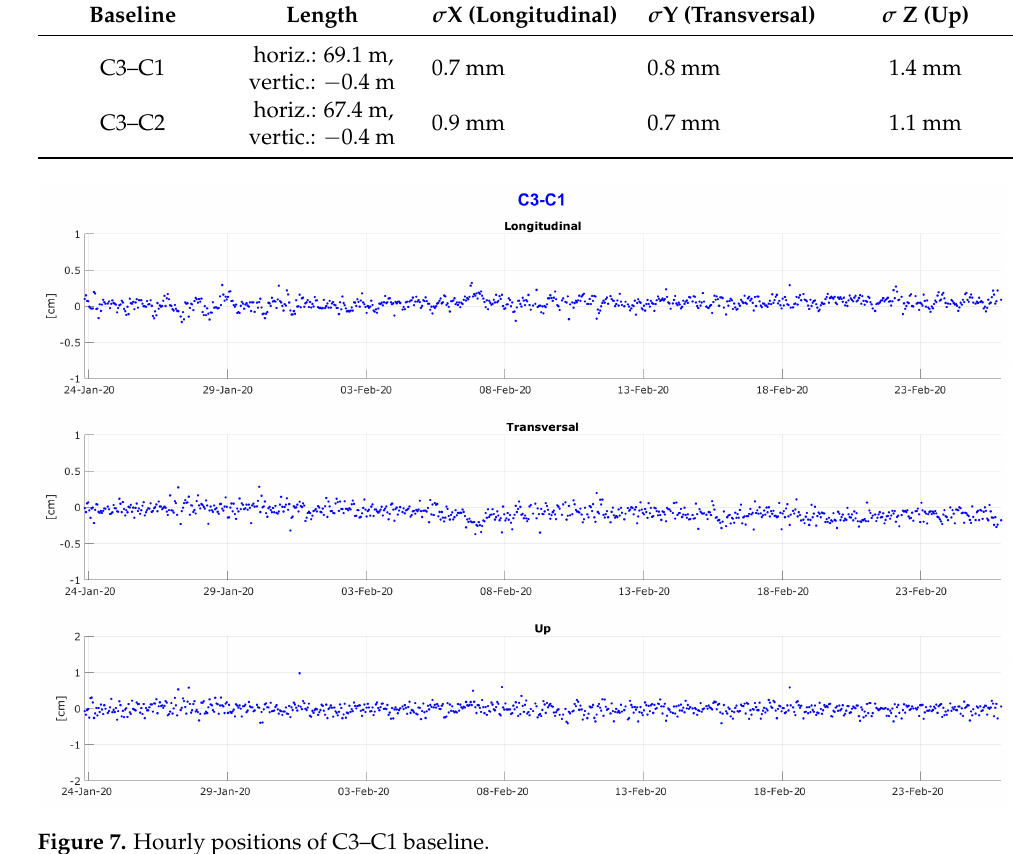
Figure 7. Hourly positions of C3–C1 baseline.